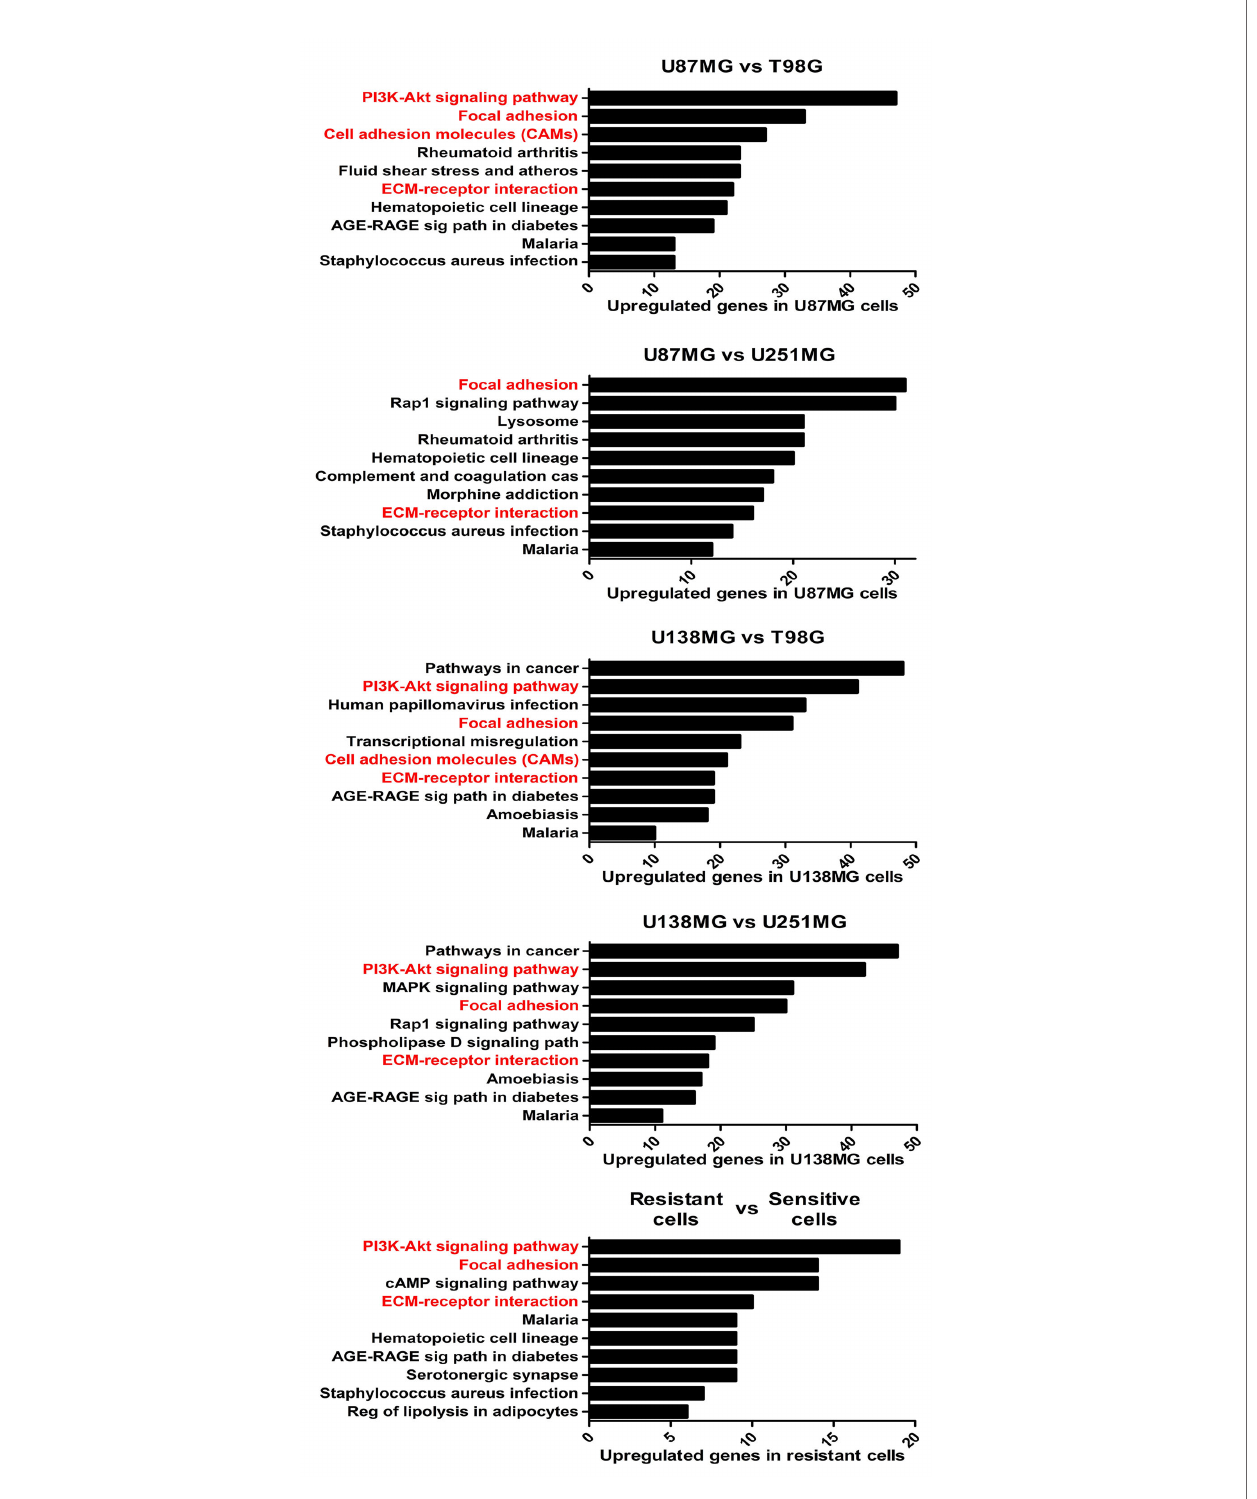
FIGURE 2 | The enriched KEGG pathways in treatment-resistant cells in comparison to sensitive cells. All genes with padj ≤ 0,0001 and log fold change > 2 in U87MG and/or U138MG cells compared to T98G and/or U251MG cells were subjected to pathway analysis by KEGG. The pathways related to cell-extracellular matrix interaction were highlighted in red. A False Discovery Rate (FDR) ≤ 0.05 was used as a threshold to select signi fi cant pathways. Graphs were plotted with GraphPad Prism 4.0